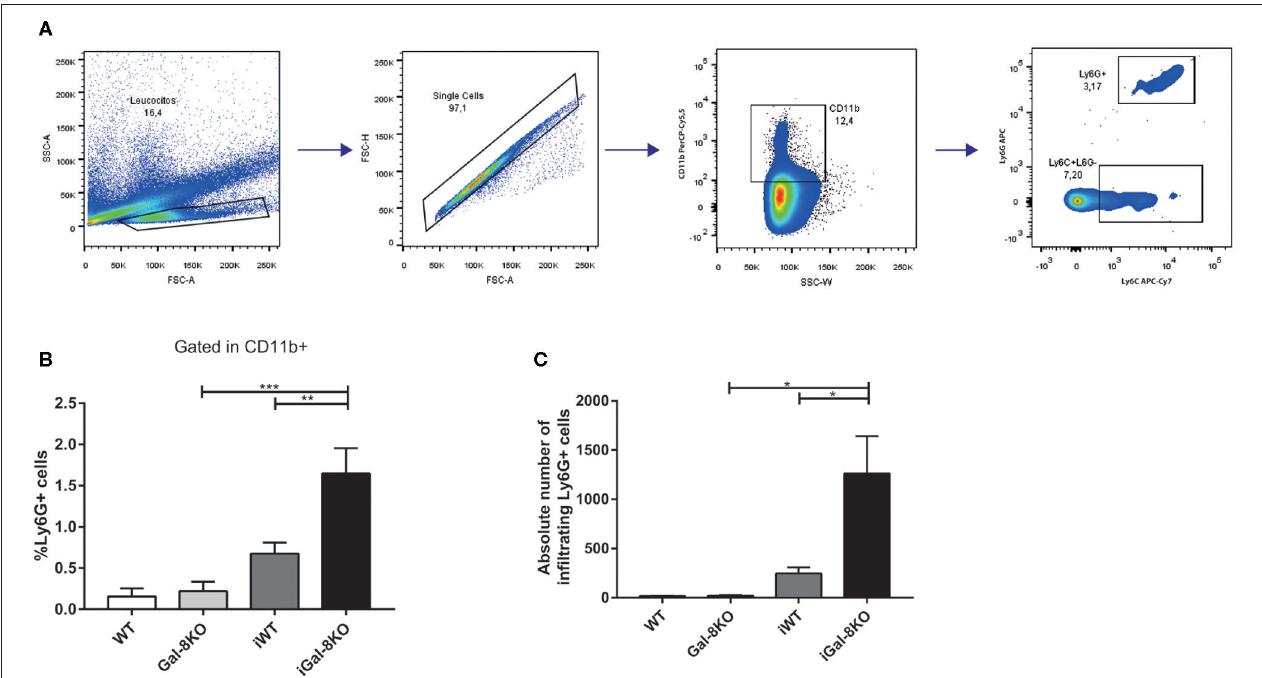
FIGURE 5 | Heart-infiltrating neutrophils in infected Gal-8KO and WT mice. (A) Flow cytometry gating strategy for heart-infiltrating neutrophils. (B) Percentage of CD11b + Ly6G + Ly6C + neutrophils. (C) Absolute number of cardiac neutrophils. Results are expressed as mean ± SEM cells of at least three independent experiments (5 animals/group). * P < 0.05; ** P < 0.01; *** P < 0.001.